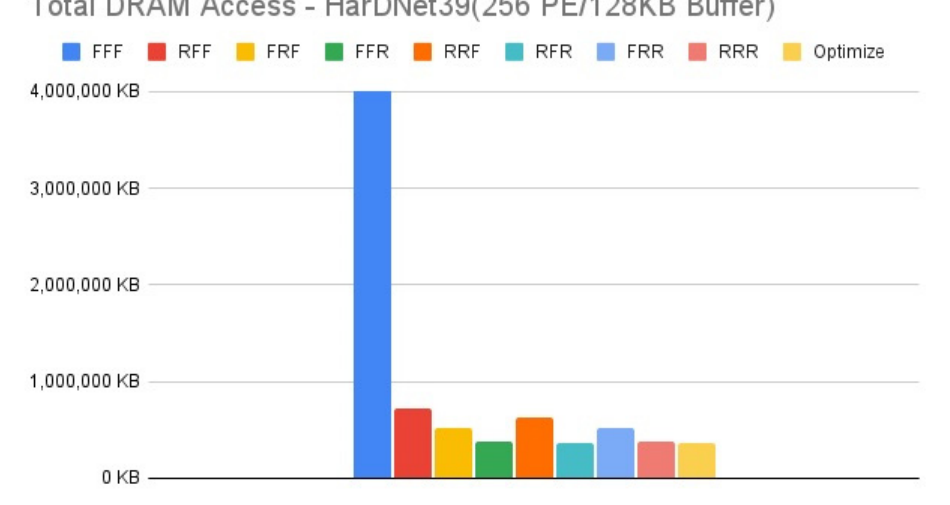
Figure 11. Total DRAM access—HarDNet39 (256 PE/128 KB Buffer).